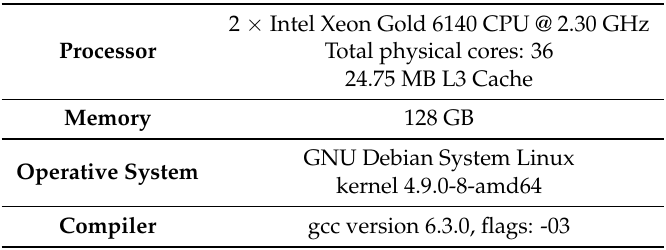
Table 2. Details of the server used for the